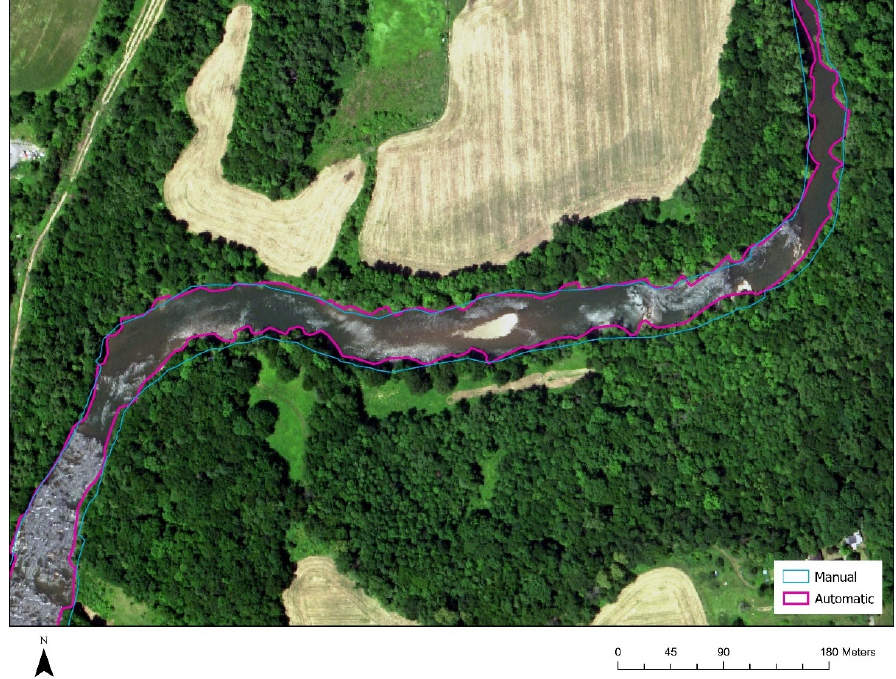
Figure 3. Example results of manual vs. automatic delineated river channel boundary. Background image is 2015 NAIP. Center of map is located near Town of Stuyvesant Falls, New York State, United States.